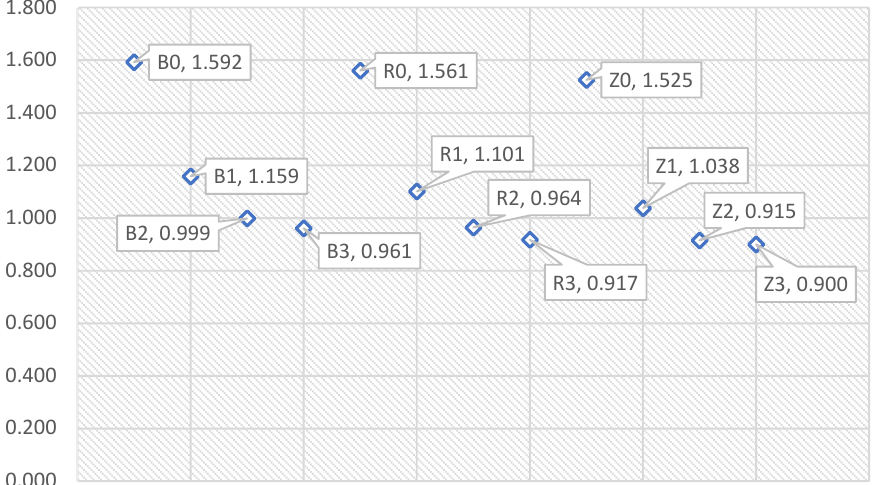
Figure 15. Energy transition index results for all scenarios.